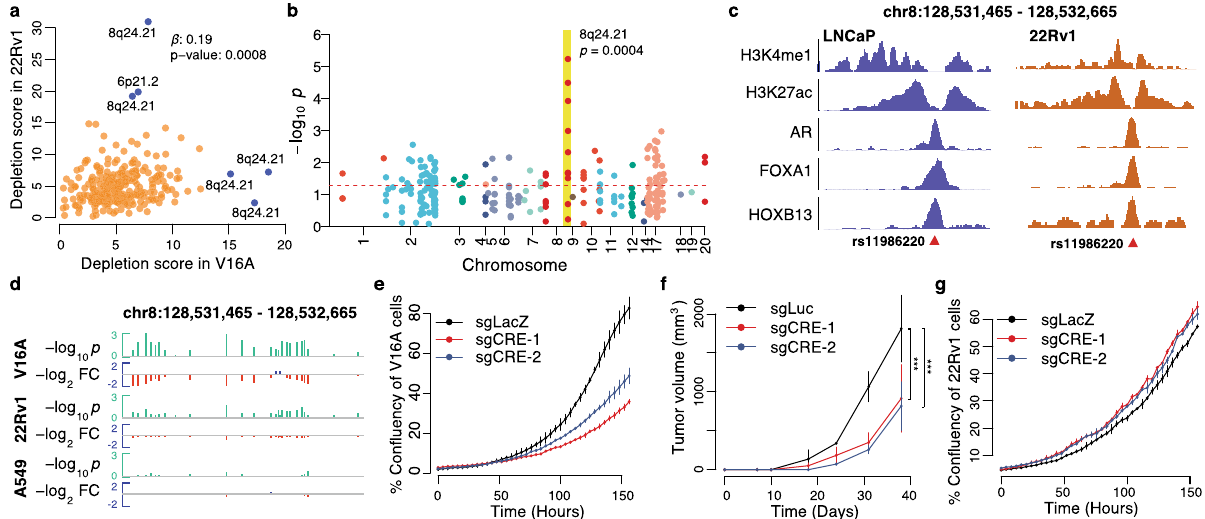
Fig. 2 The essential rCREs are enriched in 8q24.21 region. a Depletion score of rCREs in V16A and 22Rv1 cells. The blue points indicate the outlier rCREs in linear regression between the cell lines. The regression coef fi cient, β , and the p value are calculated using linear regression analysis between the depletion scores after removing the six outliers. b The essential rCREs are overrepresented in the 8q24.21 region in V16A cells ( p = 0.0004, Chi-sq test). Each circle denotes a library rCRE. The size of the circle is relative to the depletion fold change. See Supplementary Fig. 2 for other cell lines. c ChIP-seq signals of histone modi fi cations and three important transcription factors in the rCRE region of chr8:128531465 – 128532665 in LNCaP and 22Rv1 cells. Risk SNP rs11986220 is located close to the center of transcription factors binding site. d Overview of p value and fold change at day 16 compared to day 0 of the individual sliding windows targeting the rCRE chr8:128531465 – 128532665. The green bars indicate – log 2 p values; the red bar indicates fold change of sgRNAs in day 16 compared to day 0. FC fold change. Depletion p values and fold changes were estimated using the tool MAGeCK (see ‘ Methods ’ ). e Growth of V16A cells in vitro upon suppression of chr8:128531465 – 128532665 by two independent sgRNAs using dCas9-KRAB system. Data are represented as Mean ± s.d. ( n = 2). f Tumor growth in a V16A-inoculated mouse xenograft upon injection of respective sgRNAs. Data are represented as Mean ± s.d. ( n = 3). P values were estimated using ANOVA test. *** denotes a p value of 0.007. g Growth of 22Rv1 cells upon suppression of this rCRE using the same sgRNAs by dCas9-KRAB system. Data are represented as Mean ± s.d. ( n = 2). Source data are provided as a Source Data fi